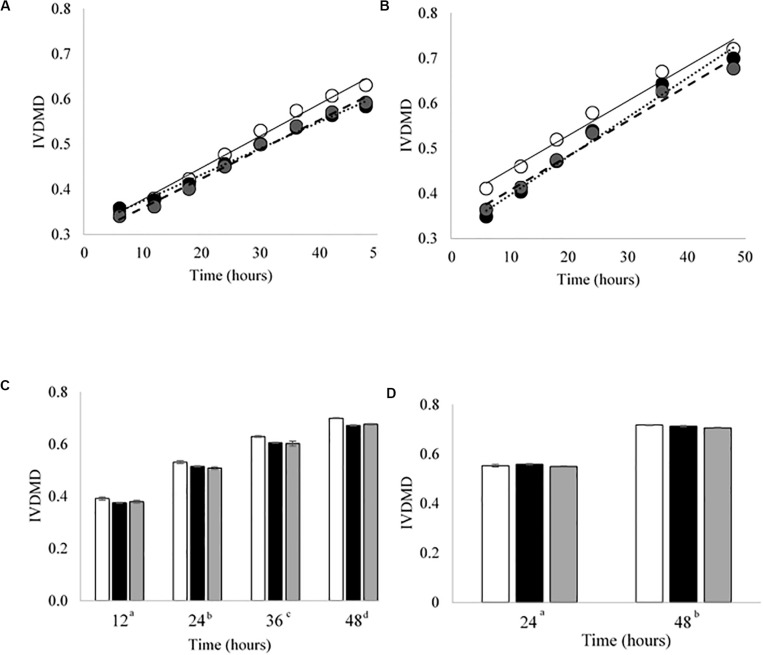
In vitro dry matter disappearance (IVDMD) for CBC1-4 (Experiment 2). Where white circles or bars = Good, black = Bad and gray = Mix. (A,B) Show the fitted values from a simple linear regression with groups for CBC1 and CBC2, respectively, error bars show pooled SEM. Equations of the lines for CBC1 are Good = 0.0071x + 0.3063, Bad = 0.0058x + 0.3153 and Mix = 0.0065x + 0.2942. For CBC2, the equations of the lines are: Good = 0.0076x + 0.3771, Bad = 0.0086x + 0.3103 and Mix = 0.0077x + 0.3298. The mean values ± standard errors are shown for (C) CBC3 and (D) CBC4. Significant differences (p < 0.05) are shown between time points by different superscript letters.